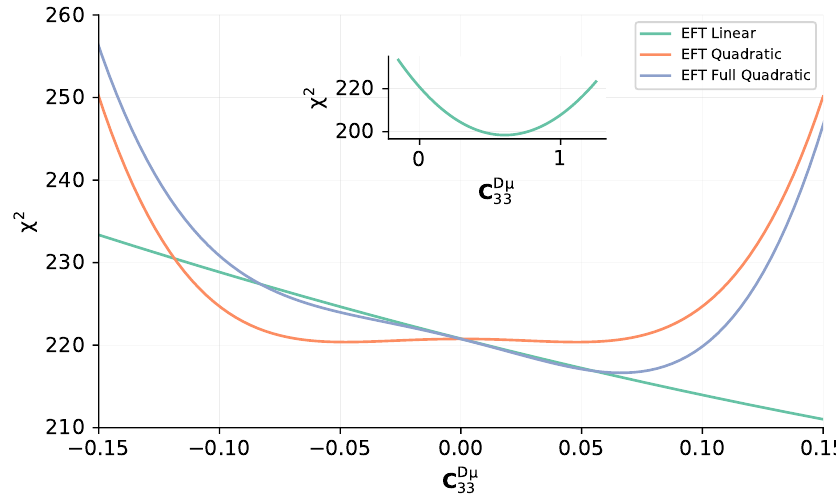
(cid:16) (cid:17) C Dµ , eq. (4.2), in scenario II. This χ 2 includes 33